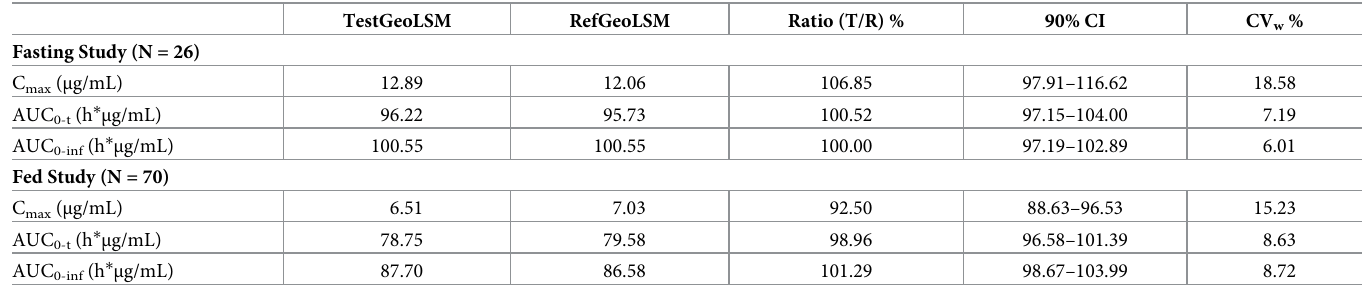
Table 4. Bioequivalence evaluation of test and reference products of calcium dobesilate capsules in healthy Chinese volunteers under fasting and fed